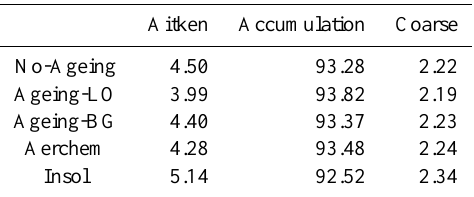
Table 4. Number weighted contributions (in %) of the individual hydrophilic modes to the total